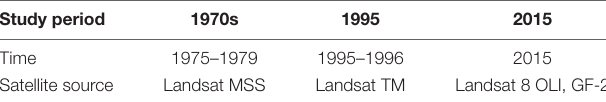
TABLE 2 | Data sources for the intertidal wetland mapping.